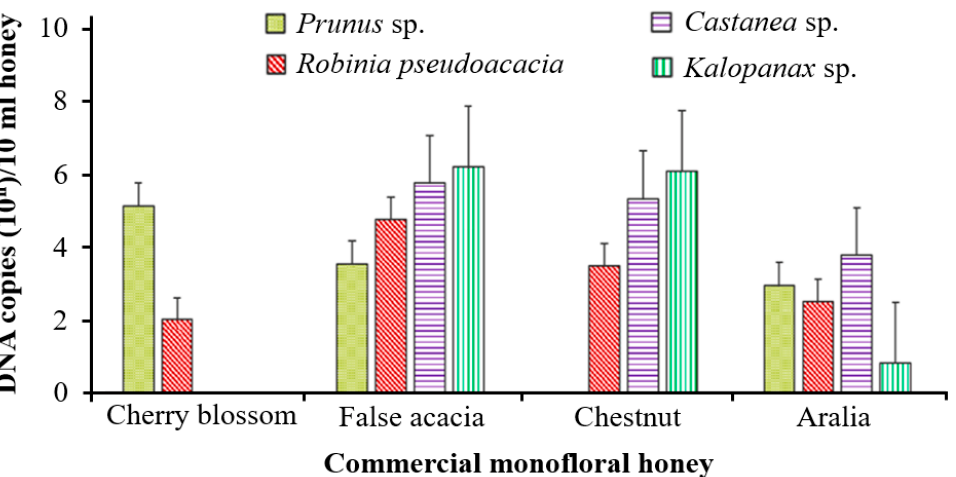
Figure 2. Quantitative detection of pollen DNA of four targeted plants in commercial honey samples. The quantity of DNA corresponding to Prunus sp., R. pseudoacacia , Castanea sp., and Kalopanax sp. was calculated from the monofloral honey samples of cherry blossom, false acacia, chestnut, and aralia, respectively, purchased in Korea. The result was calculated from triplicate PCRs (mean + standard deviation).